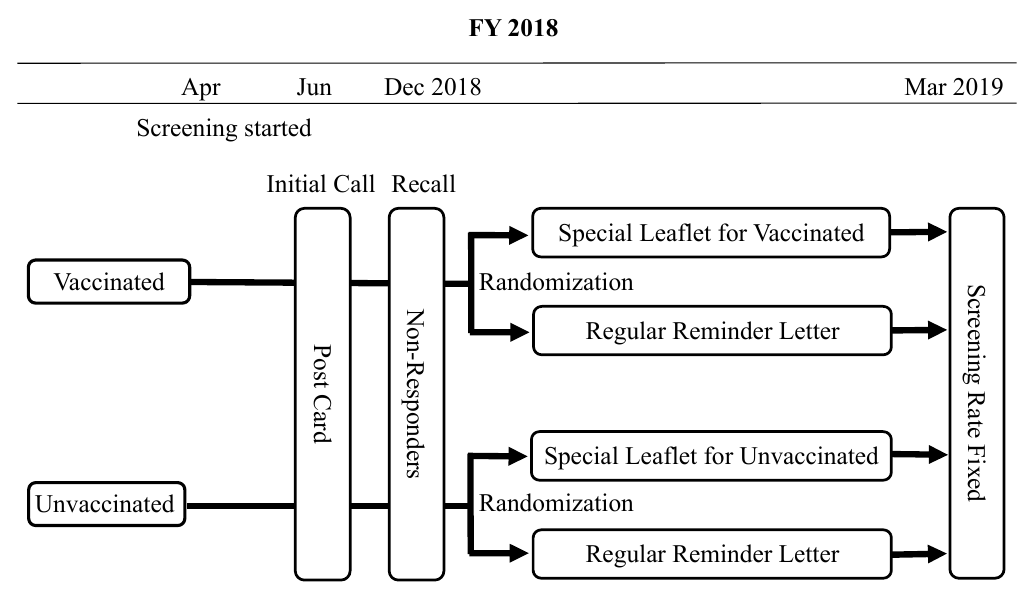
Figure 1. The study schema of randomized comparison of information leaflets tailored to human papillomavirus (HPV) vaccination status versus the standard reminder letter.